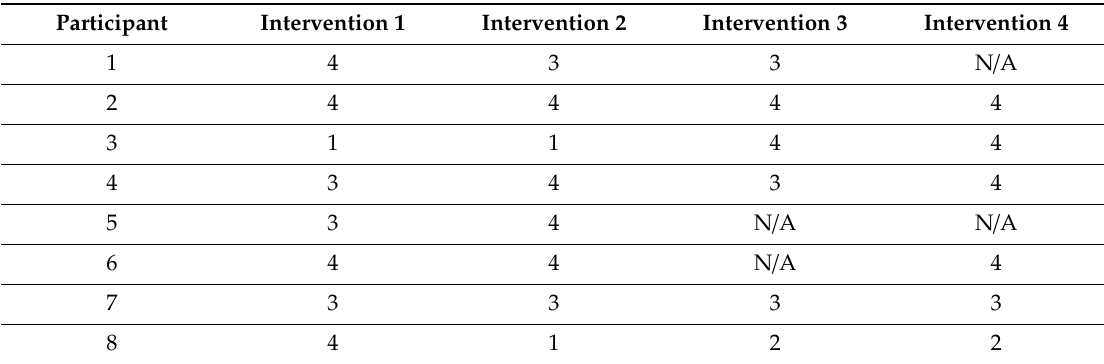
Table 3. Enjoyment scale results from hydrotherapy group interventions.